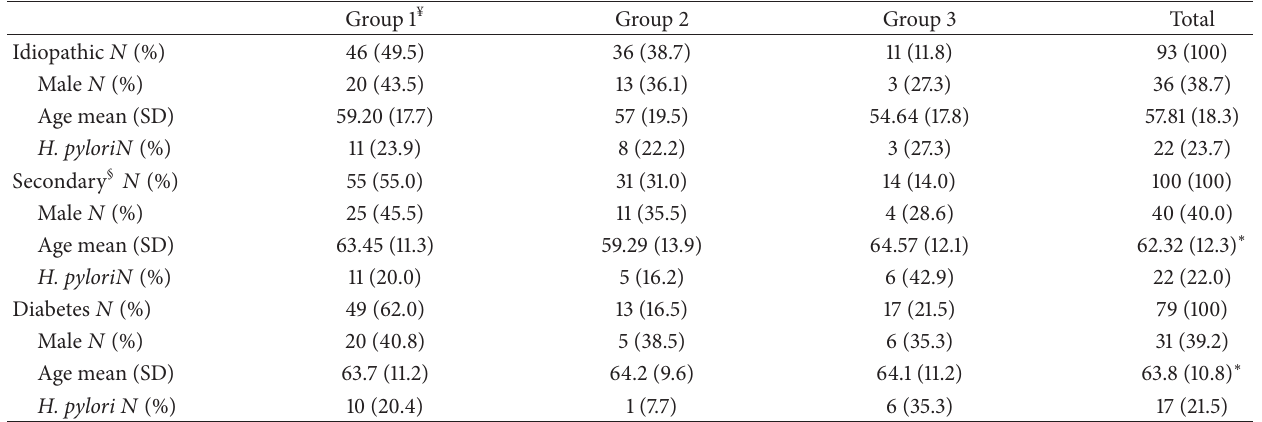
Table 3: Clinical associations of